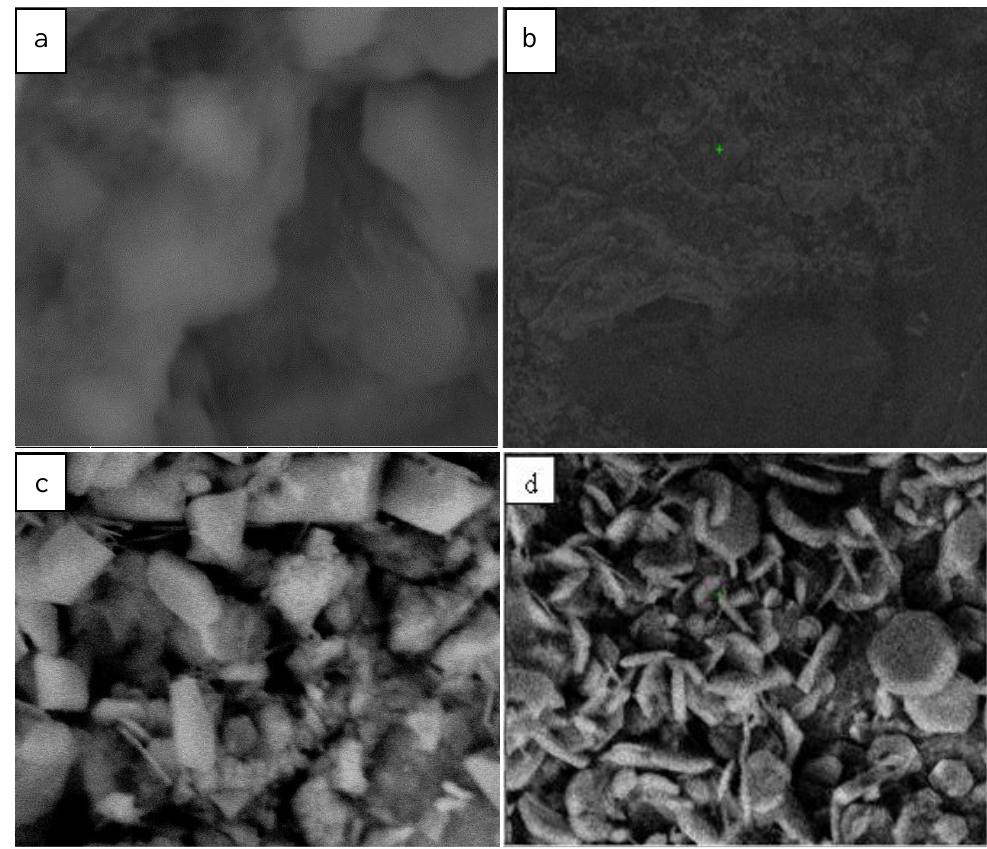
Fig.10: SEM photograph of glass for different doping concentrations of graphene oxide thin films (a) 2%, (b) 4%, (c) 6% and (d) 8% wt.